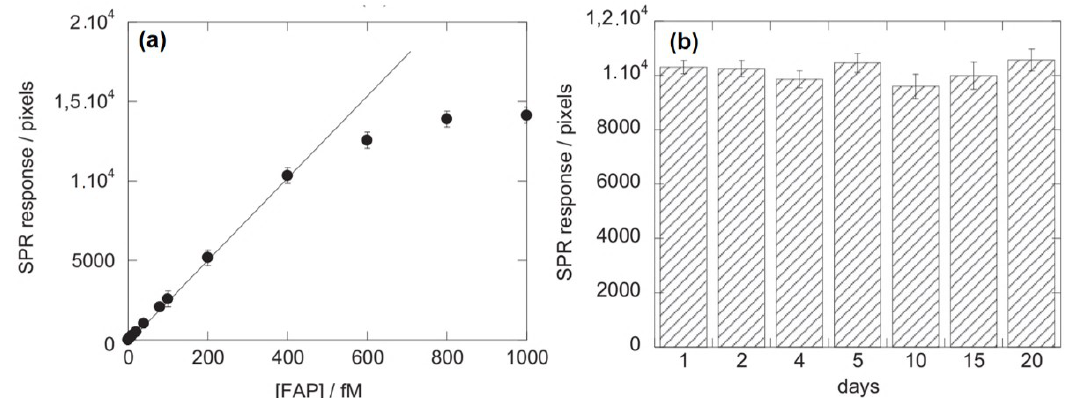
Figure 9. ( a ) SPR response at different FAP concentrations from 10 fM to 1 µm. ( b ) Repeatability of FAP detection for 20 days using the same sensor (adapted with permission from Reference [43], copyright Elsevier).